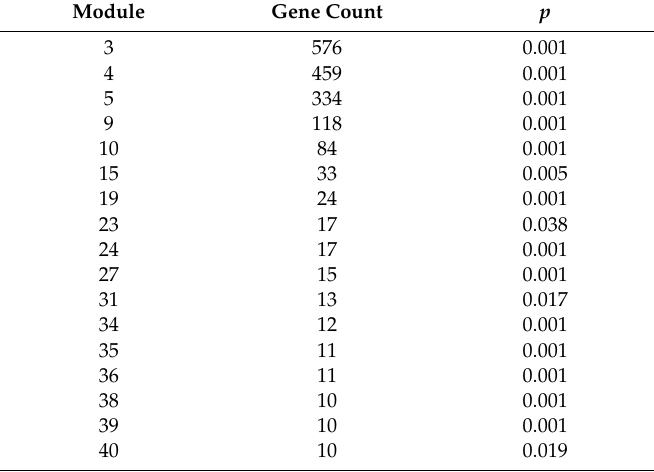
Figure 1. Gene expression heatmaps of co-expression modules that were identified from consensus lmQCM network modeling and that showed differential gene regulation with respect to FOXO1-PAX3/7 fusion status (see Table 1). Expression values have been organized by hierarchical clustering to better visualize absolute expression values (left). To better visualize potential differences between PAX3 and PAX7 type fusions, gene expression values were mean centered and normalized from − 1 to 1 for each module separately (right). Table 1. Differential co-expression analysis of modules that were significantly different in fusion negative vs positive cases. For brevity, only modules with significant ( p < 0.05) differences are reported (see Table S1 for full results).